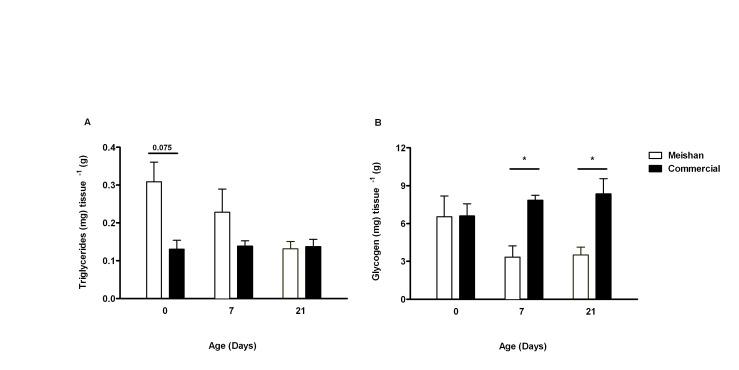
Liver composition between age and breed.The effect of breed and postnatal age in liver composition between Meishan (open bars) and commercial (closed bars) piglets: (A) Triglyceride content and (B) glycogen content. *; p<0.05: statistical difference between the same postnatal age groups. Bar graphs illustrate means ± SEM.